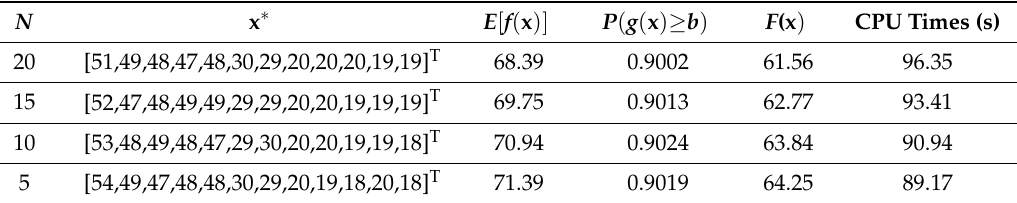
Table 2. The excellent solution x ∗ , the corresponding E [ f ( x )] , P ( g ( x ) ≥ b ) , F ( x ) and the consumed CPU times for four values of N in large problem.